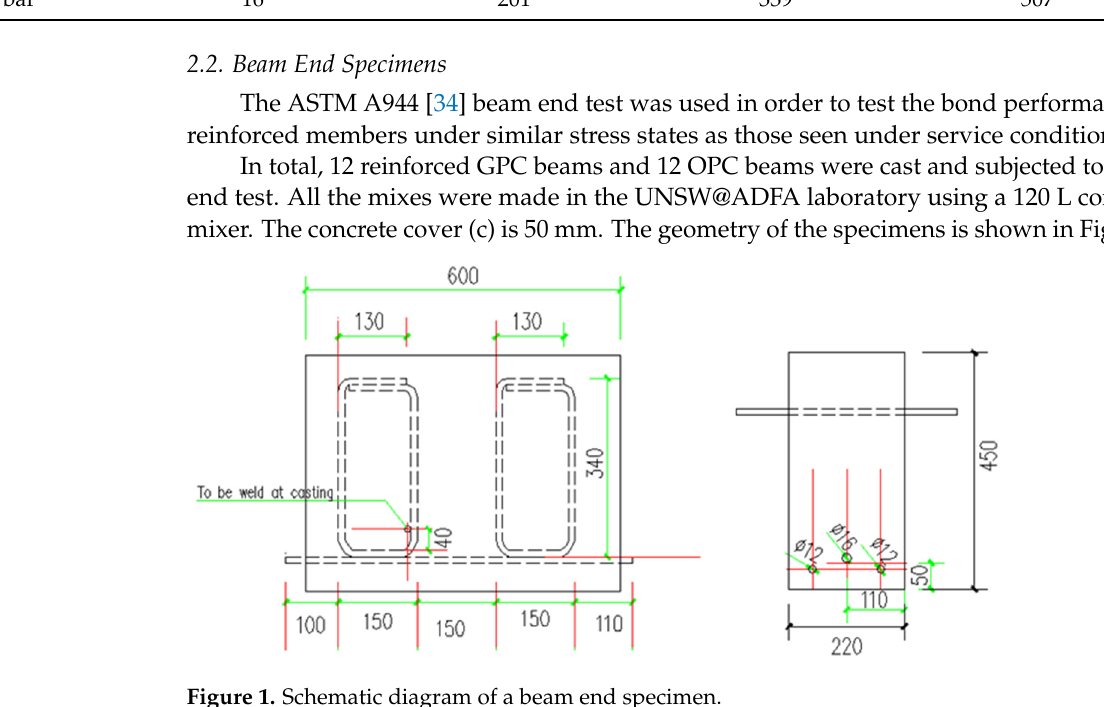
Figure 2. Sketch of the beam end pull out test. The specimens were loaded using an INSTRON ® hydraulic (MEAS, Virginia, the US) actuator with a loading rate of 2 kN/min for plain bars and 12 kN/min for ribbed bars. The test bar was pulled out by the SHIMADZU @ MWG-100kNA (SHIMADZU, Kyoto, Japan) wedge grip under the designed loading rate during the test. The relative slip at the free Load